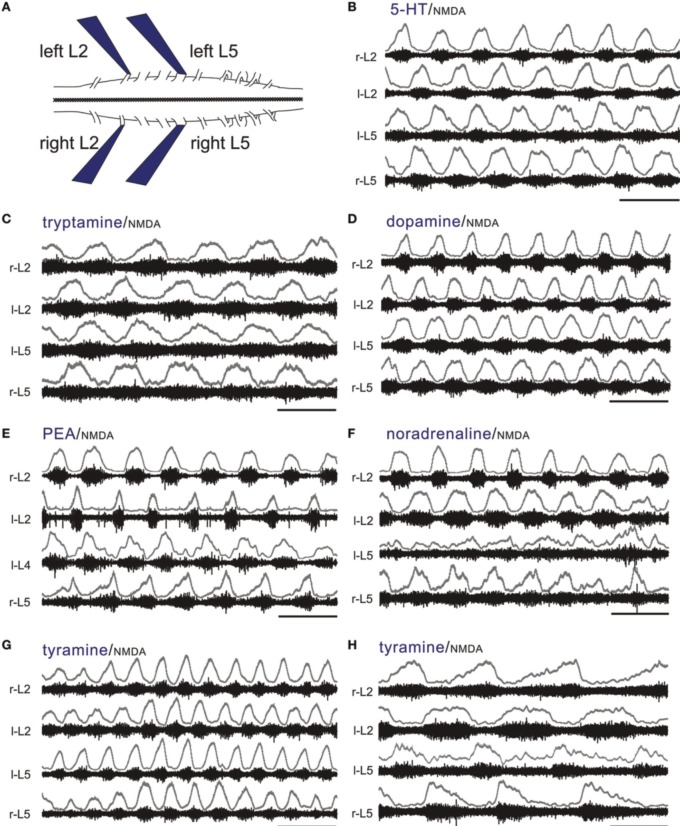
The TAs and monoamines can all produce a continuous LLA pattern. (A) Experimental setup (left). All of the electrophysiological experiments use the thoraco-lumbar isolated neonatal rat spinal cord maintained in vitro. Suction electrodes are placed on lumbar L2 and L5 ventral roots bilaterally to monitor population motoneuron flexor and extensor activity, respectively. LLA is shown as an alternation between right and left L2 flexors, with each flexor rhythm alternating with the L5 extensor rhythm on the same side. (B) Typical locomotor rhythms observed with co-application of 5-HT and NMDA. (C–G) Tryptamine, dopamine, PEA, NA, and tyramine can also produce a continuous LLA pattern comparable to 5-HT in the presence of NMDA. (H) Tyramine can also produce a slower LLA pattern. The upper traces in gray at each lumbar root represent the rectified/low-pass filtered equivalent of the raw waveforms below them. Scale bars are 10 s in all panels.